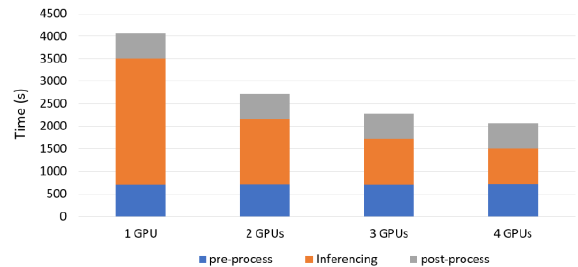
Figure 11. Comparison of time taken for multiple GPUs to process 1600-million-pixel images in a single HPC node.